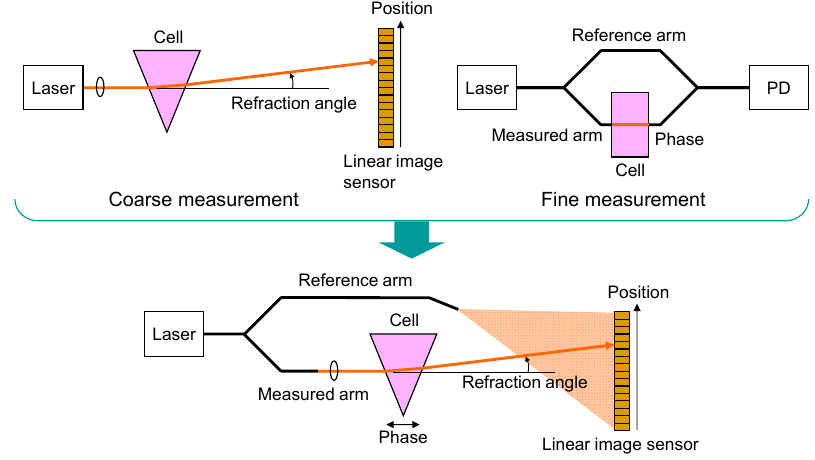
Figure 1. Concept of proposed refractive index sensor.